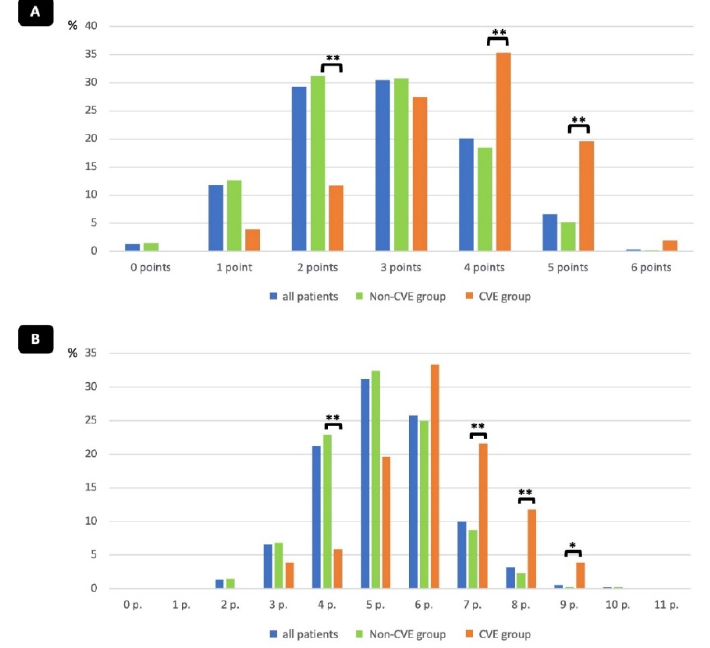
Figure 3. Percentage of patients in the derivation cohort stratified by risk score models I and II. Percentage of patients in each group stratified by risk score model I ( A ) and model II ( B ). Groups are shown with p -values (* p < 0.05, ** p < 0.01).